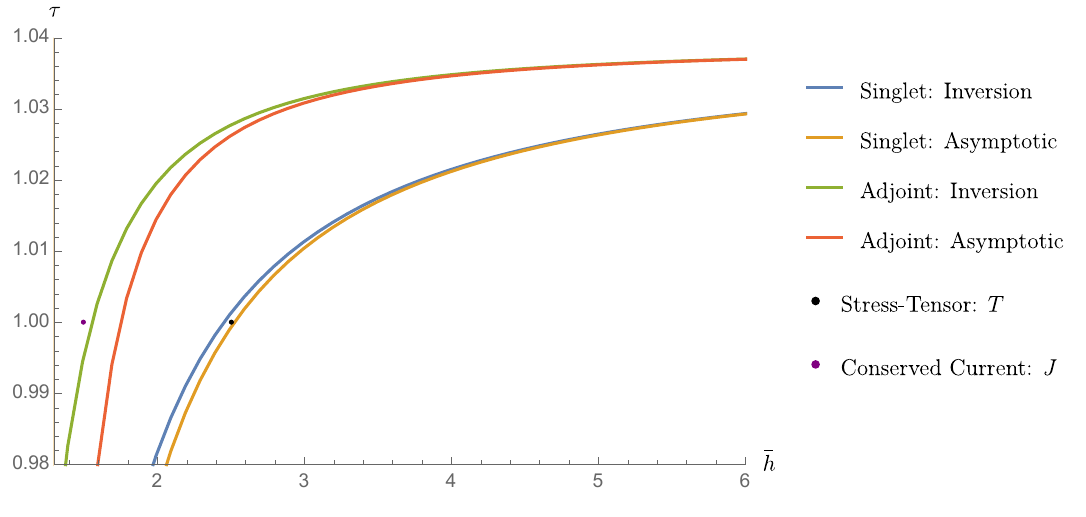
Figure 3 . Spectrum of [ φφ ] ( I ) stress tensor and conserved current which have twist